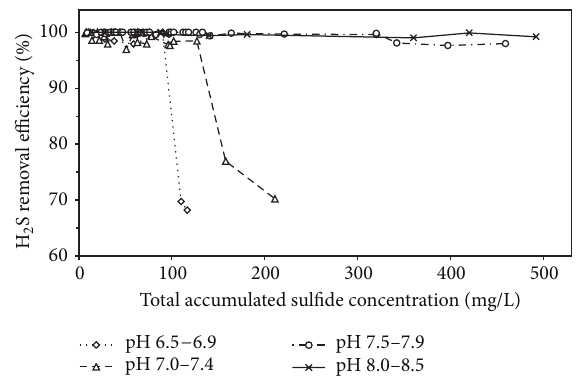
Figure 7: Effect of accumulated sulfide on bioconversion efficiency at various pH